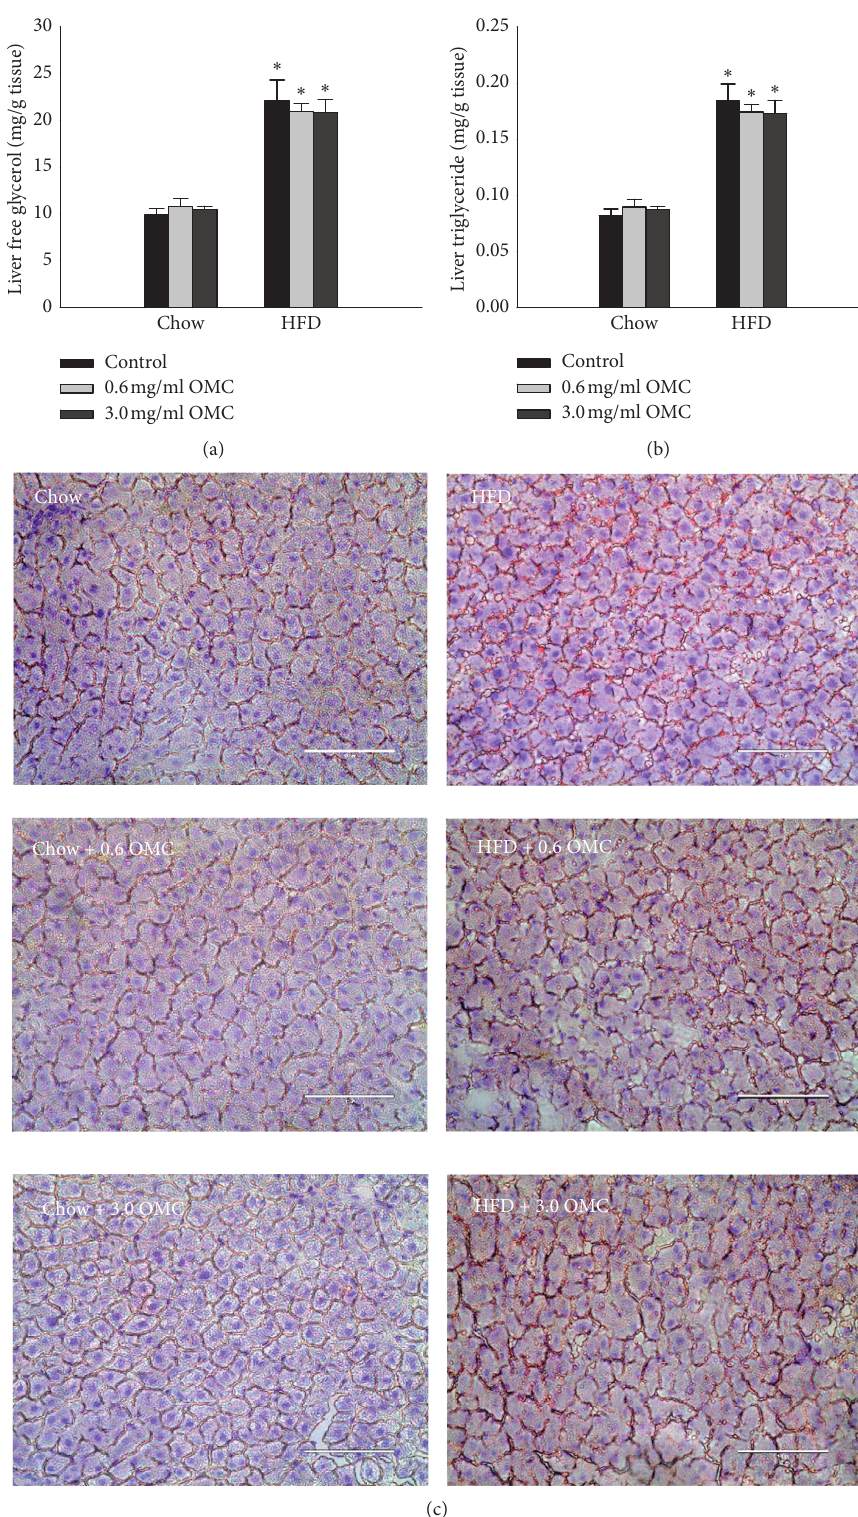
Figure 4: Hepatic lipid accumulation. (a) Free glycerol and (b) triacylglycerol concentrations in liver samples isolated from n � 5 animals in each group. Data are expressed as mean ± SEM and analyzed by two-way ANOVA, ∗ p < 0 . 05 vs respective Chow control. (c) Representative images of Oil Red O stained hepatic tissues collected from male Sprague-Dawley rats in each treatment group. Frozen tissue sections were stained with Oil Red O to show neutral triglycerides and lipid content and counterstained with hematoxylin to show nuclei (blue). Livers from rats fed HFD for 10 weeks showed evidence of simple